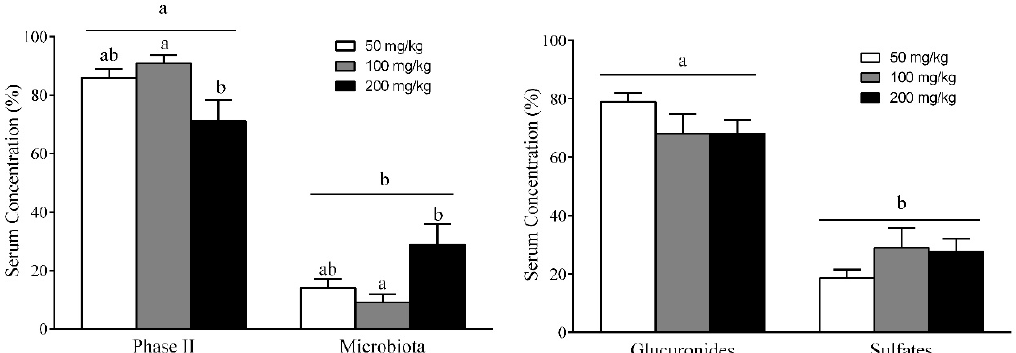
Figure 4. Serum resveratrol metabolites. The rats were fed the STD or CAF diet for 9 weeks. Then, the STD and CAF rats were treated orally with RSV (50, 100 or 200 mg per kg of body wt) or vehicle for 3 weeks. The metabolites present in serum were classified as ( A ) phase II RSV metabolites or microbial metabolites and as ( B ) glucuronide or sulfate metabolites. Data are expressed as the mean ± SEM, n = 6. a,b denote significant differences between groups ( p < 0.05; two-way ANOVA and Bonferroni’s test). Table 1. The results obtained for each metabolite (µM) present in serum respect each group of rats treated with RSV.